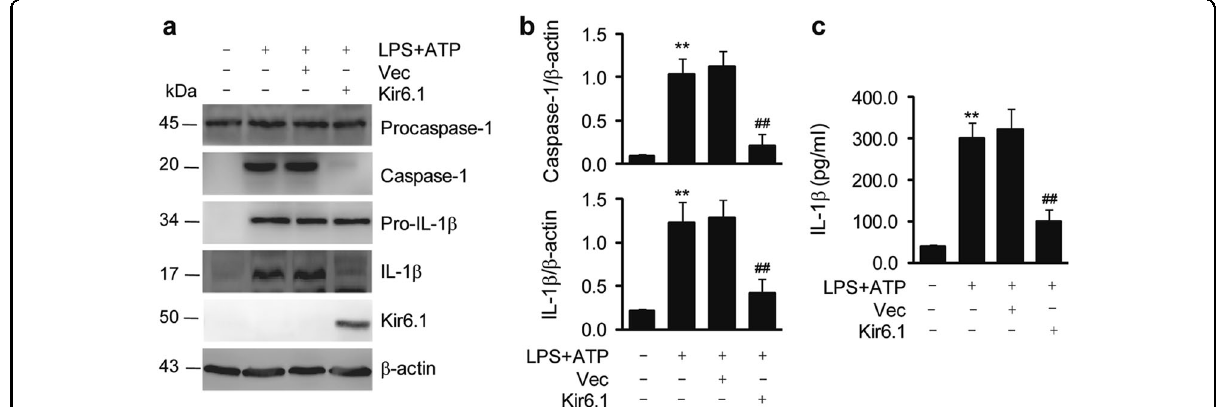
Fig. 3 Kir6.1 inhibits NLRP3 in fl ammasome activation in A549 cells. a Inhibition of the NLRP3 in fl ammasome by Kir6.1 in A549 cells. A549 cells were transfected with Kir6.1 or vector alone for 48 h and then treated with LPS plus ATP. b Quanti fi cation of caspase-1 (upper panel) and IL-1 β (lower panel), as shown in ( a ). c Concentrations of IL-1 β in A549 cells measured by ELISA. The data shown are the mean ± SEM from four independent experiments. ** p < 0.01 vs cells with no stimulation and transfection and ## p < 0.01 vs cells stimulated with LPS + ATP and transfected with